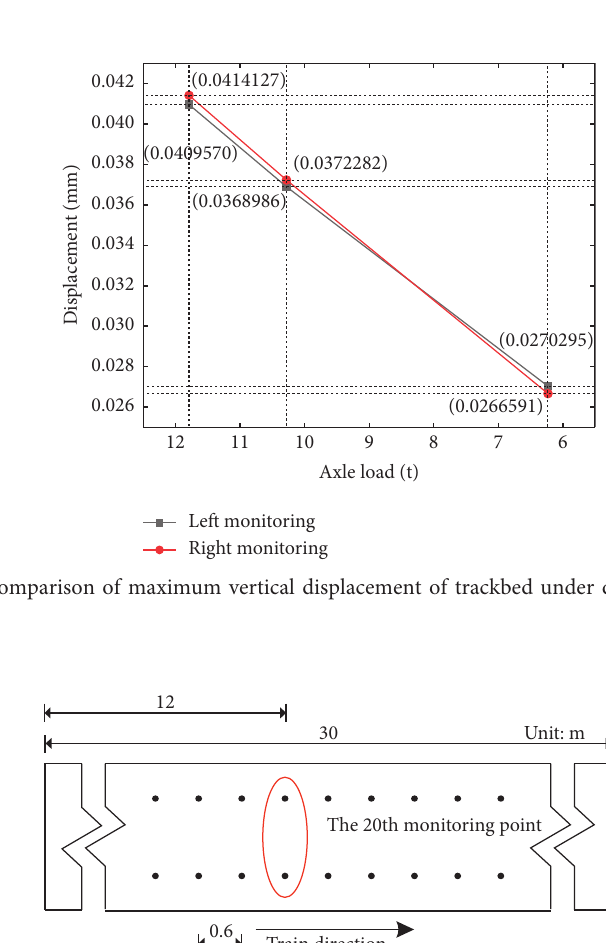
Figure 9: (a) Time-history and (b) amplitude-frequency curves of vertical displacement at the right monitoring point of trackbed under different axle loads.